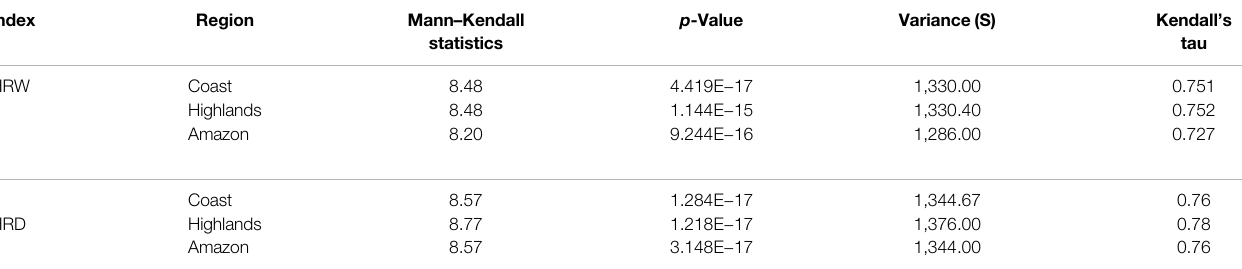
TABLE 5 | Mann – Kendall model results of the mean of the all-station index in each region derived from the IPSL model. Index Region